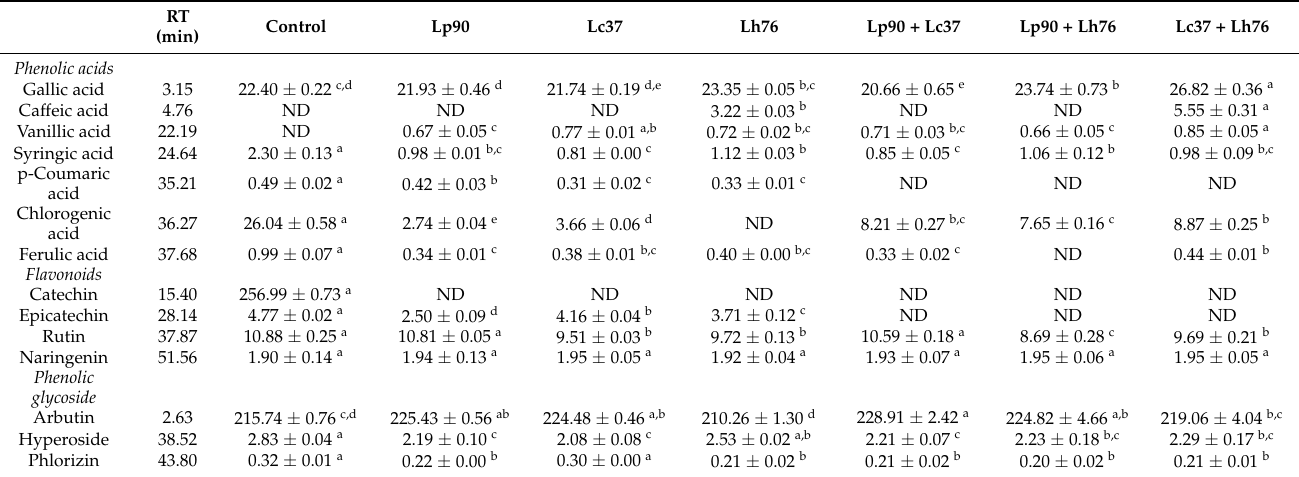
Table 2. Phenolics profile in pear juice fermented by monoculture and binary mixture of lactic acid bacteria